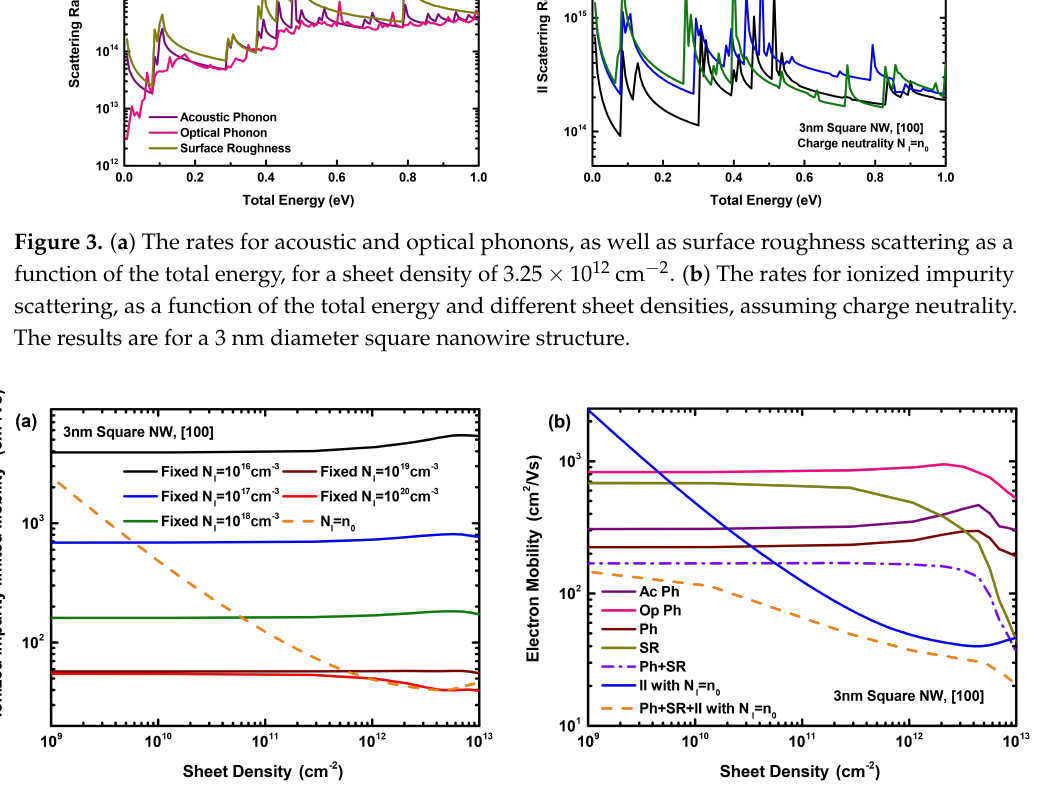
Figure 4. ( a ) Ionized impurity limited electron mobility as a function of the sheet density considering different fixed ionized impurity densities as well as charge neutrality. ( b ) Electron mobility as a function of the sheet density considering acoustic, optical, total phonon, surface roughness, and ionized impurity (assuming charge neutrality) scattering separately, as well as the combined mechanisms. The results are for a 3 nm diameter square nanowire